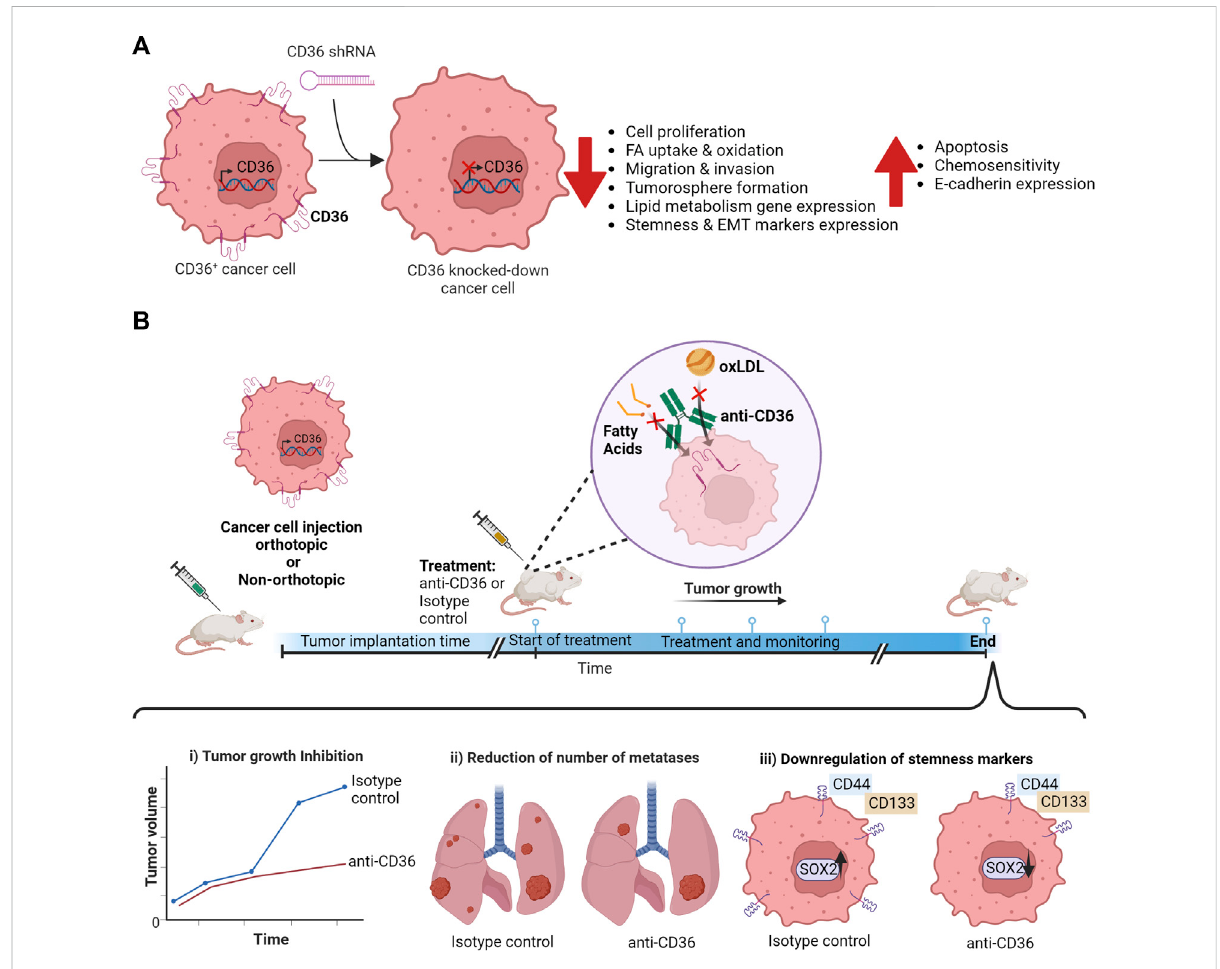
FIGURE 1 Impact of CD36 blockage on cancer cells. (A) Changes in cancer cell functions on CD36 + cancer cells generated by CD36 knock-down using CD36-targeting shRNA. (B) Experimental timeline summarizing the effects of anti-CD36 antibodies in vivo.